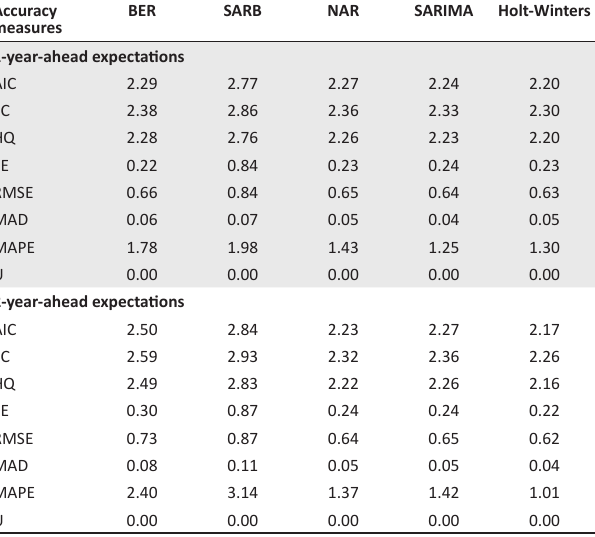
TABLE 4: Overall accuracy – Quarterly